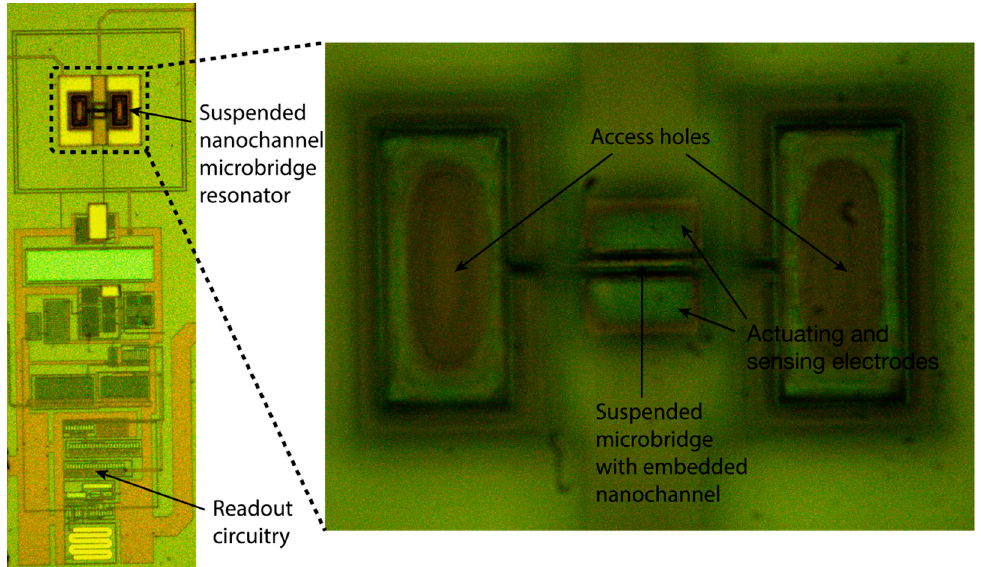
Figure 4. Optical image of the suspended nanochannel microbridge resonator and its adjacent CMOS readout circuitry at some intermediate step in the emptying and releasing process.